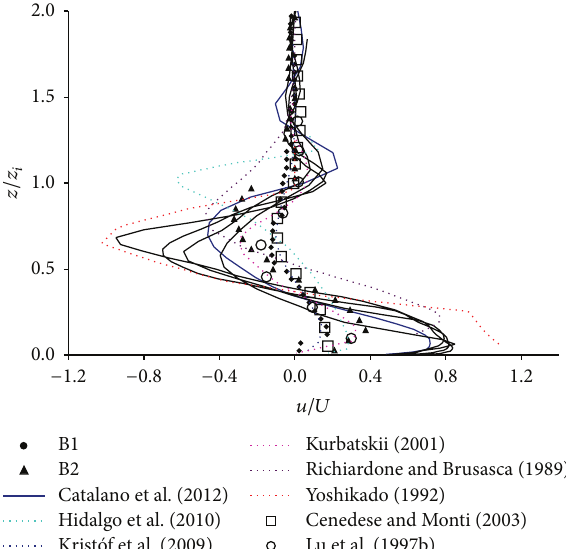
Figure 35: Normalized horizontal velocity component vertical profiles at 𝑥/𝐷 = 0.5 for the numerical simulations and the laboratory experiments, compared with literature data: numerical results of Catalano et al. [92], Hidalgo et al. [93], Krist´of et al. [94], Kurbatskii [95], Richiardone and Brusasca [96], and Yoshikado [88]; laboratory experiments of Cenedese and Monti [97] and Lu et al. [86].